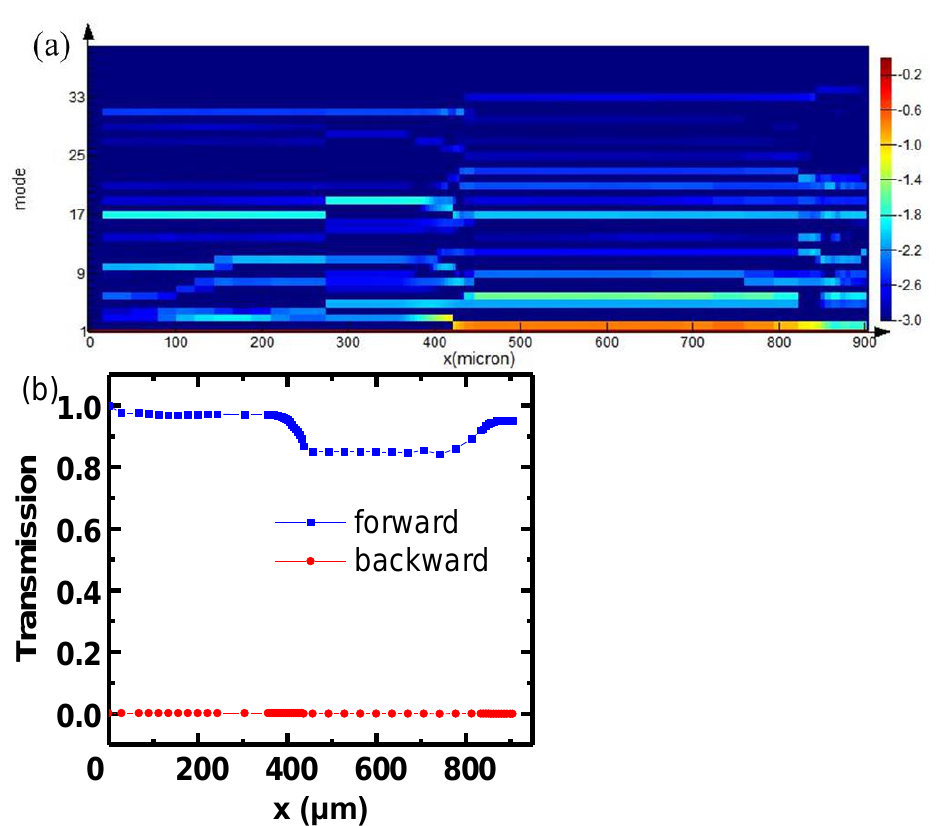
Figure 9. ( a ) The magnitude of the forward propagating mode coefficients along the length of the edge coupler; ( b ) the magnitude chart of the forward and backward propagating fundamental mode coefficients along the length of edge coupler. In the simulation, 40 modes are calculated.